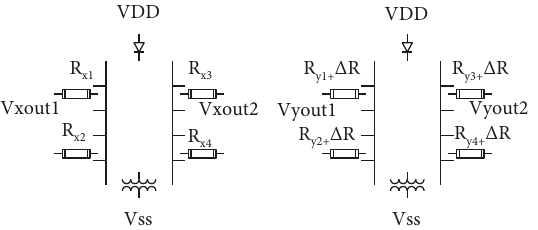
Figure 6: Schematic diagram of the working principle of the x -axis and y -axis of the acceleration sensor: (a) x -axis; (b) y -axis.